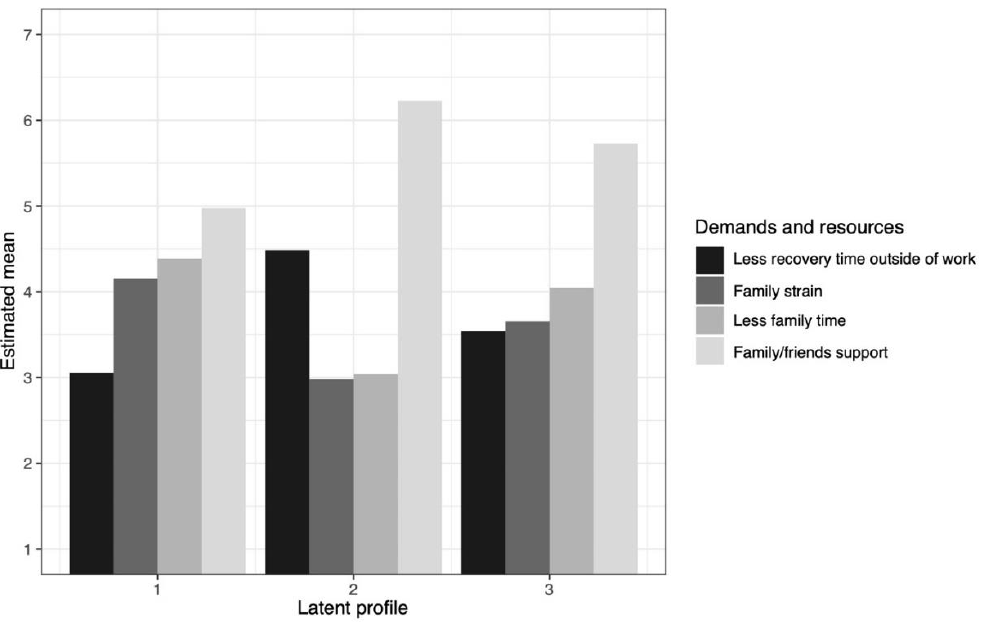
Figure 7. Latent profile solution for demands and resources (estimated means: lack of safety material, sufficient educational working material, restrictions concerning activities with the children, clear and timely information on how to deal with covid at the work, challenging parent interaction and fear of infection; 7-point Likert scales; 1= never to 7= always/every day)